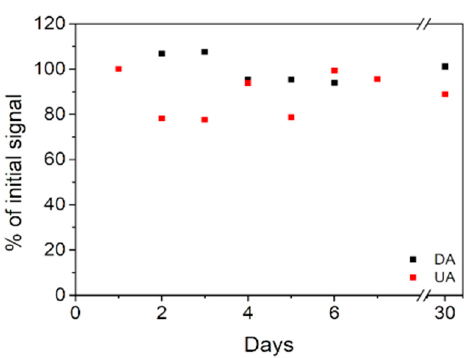
Figure 9. Long-term stability of the GCE / PFSG electrode in DA and UA detection.